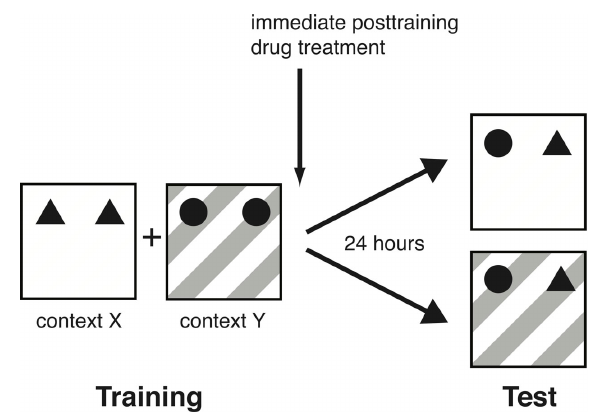
FIGURE 1 | Schematic diagram of the experimental design. On the training session, rats were placed in one distinctive context (X) with two identical objects (A1 and A2), followed by another distinctive context (Y) with two other identical objects (B1 and B2). They were trained in each context for 3min (norepinephrine experiment) or 10min (propranolol experiment). On the 24-h retention test, they were placed in context X or Y with one copy of both training objects (A3 and B3) and were allowed to explore them for